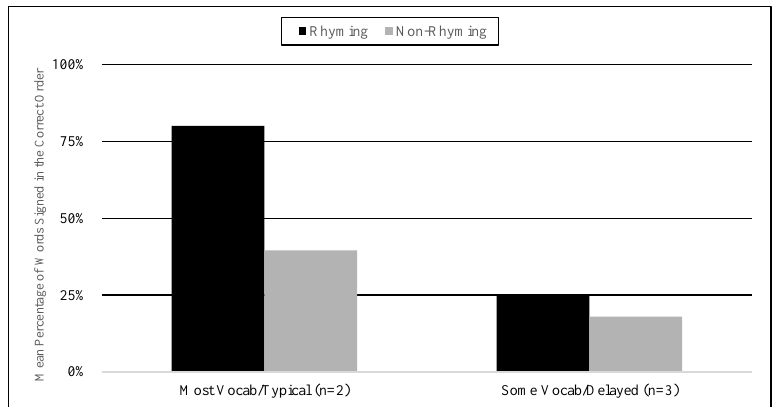
Figure 6. Mean Percentage of Words Signed in the Correct Order Across Phases in Some Vocabulary/Delayed and Most Vocabulary/Typical Language Groups.